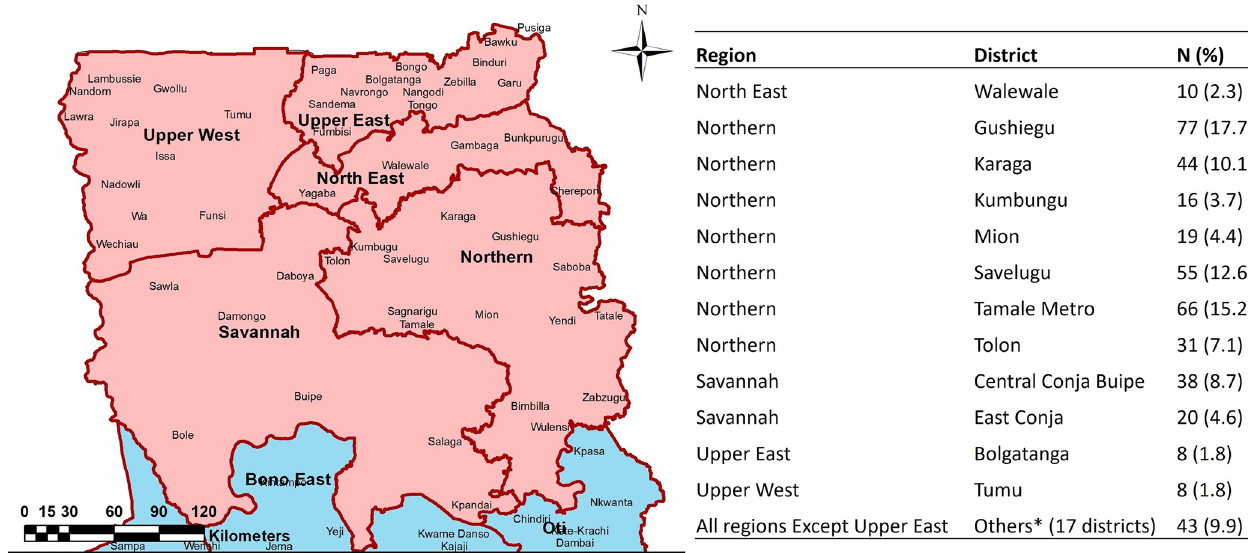
Fig 5. Geographical origin of slaughtered cattle. Animals sampled came from 29 districts within Northern Ghana. The base map as well as the copyright information for use of the base map files can be obtained at https://data.humdata.org/dataset/cod-ab-gha. No changes were made to the base map files. � Other districts include: Dabo, Damongo, East_Mamprusi, Gulu, Hamile, Janga, Kabulpe, Kpalbei, Laura, Nalerigu, Nanton, Sagnerigu, Sissala West, Sissala North, West Gonja, Wa West, and West Mamprusi.